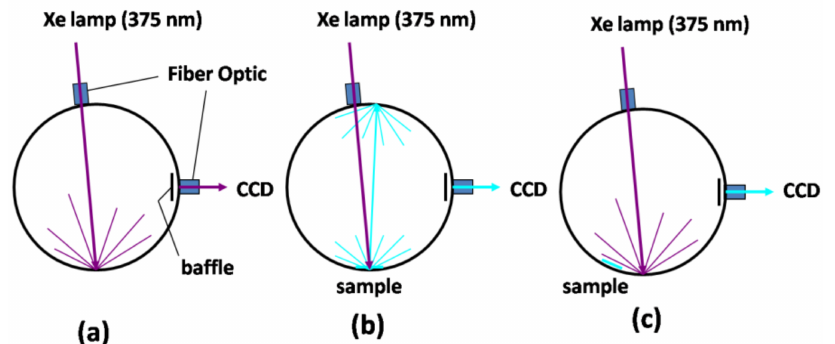
Figure 1. A diagrammatic presentation of the optical paths of the emitted photons from the excitation light source and the a-SiN x O y films in the integrating sphere during PL QY measurement processes. ( a ) No a-SiN x O y samples; ( b ) the excitation light shines directly onto a-SiN x O y samples; ( c ) the excitation light shines onto a-SiN x O y samples